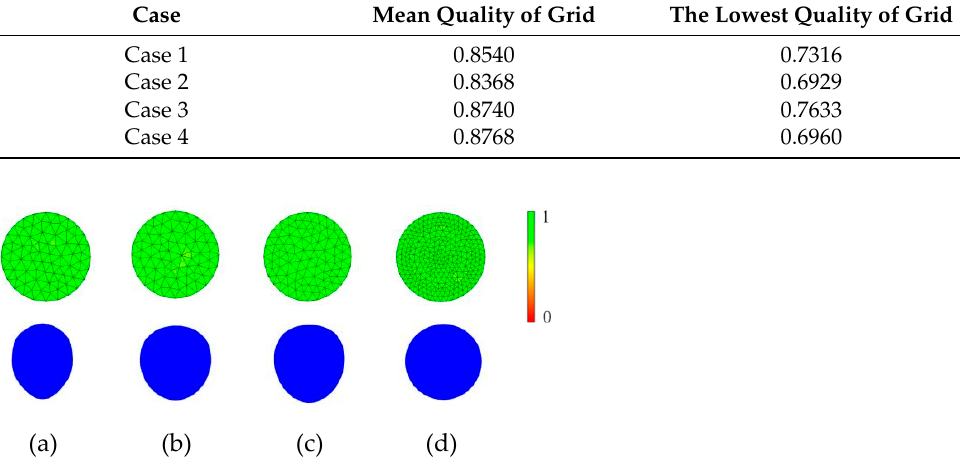
Figure 2. Grid distribution of water droplet and its shape falling in air at 283.15 K, 0.05 s: ( a ) case 1; ( b ) case 2; ( c ) case 3; ( d ) case 4.